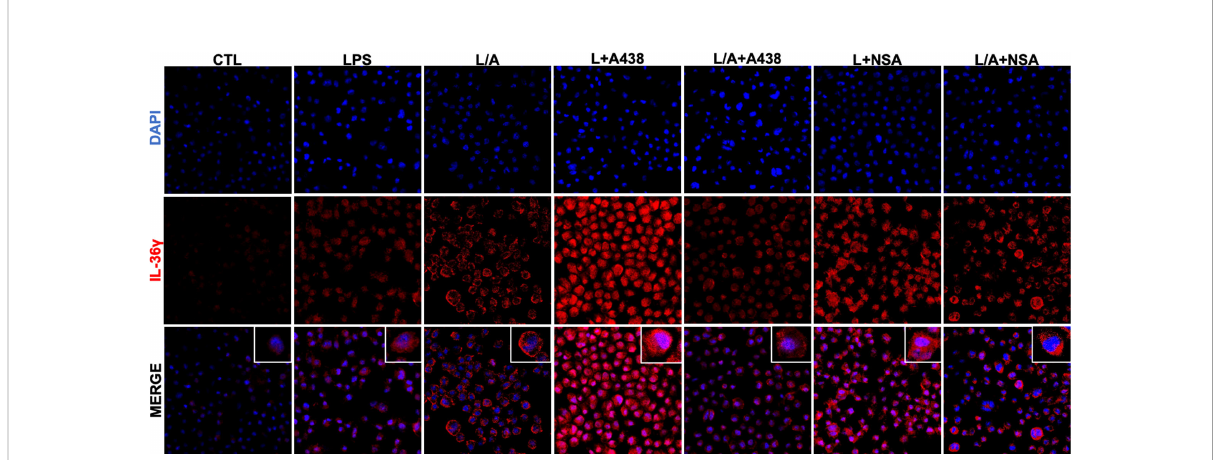
FIGURE 3 IL-36 g is localized in the cytoplasm of IC21 macrophages. IL-36 g localization in IC21 macrophages in control, LPS, LPS/ATP (L/A), LPS/ATP +A438, and LPS/ATP+NSA conditions. nuclei staining (DAPI), IL-36 g (Alexa